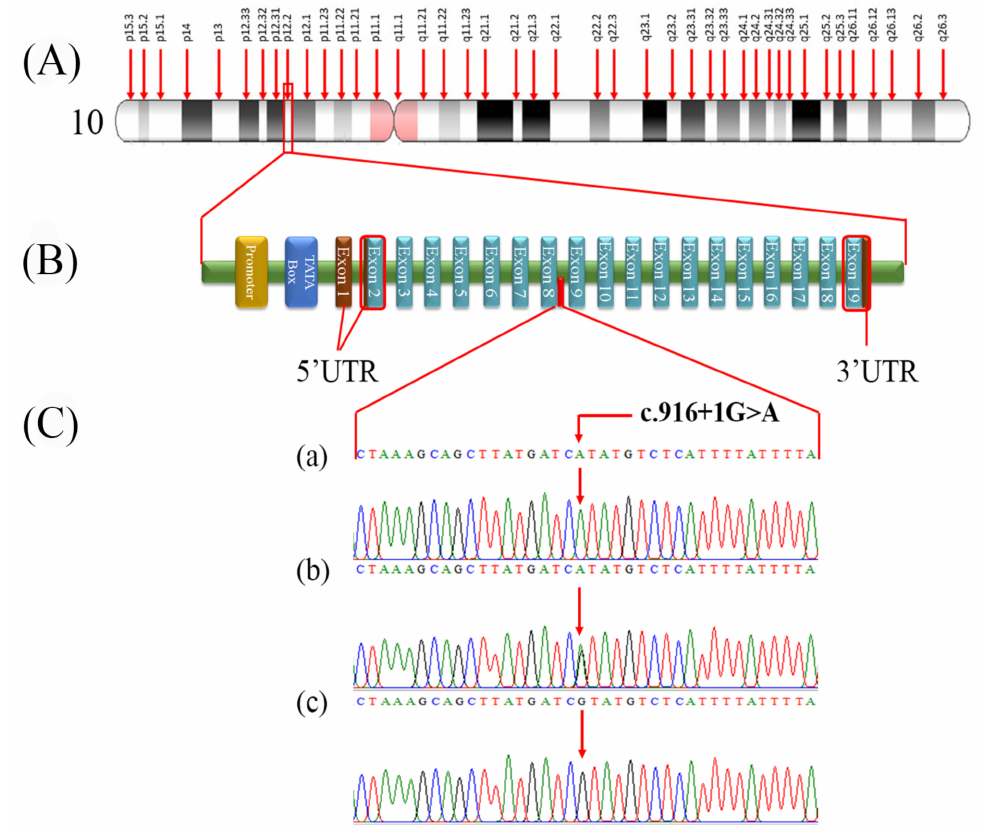
Figure 2. ( A ) shows the cytogenic location of the ARMC3 gene on chromosome 10; ( B ) indicates the typical structure of ARMC3 containing 19 exons and the location of the ARMC3 variant by the red bar between the exons 8 and 9. ( C ) Chromatograms. (a) Affected individual, (b) carrier, and (c) unaffected